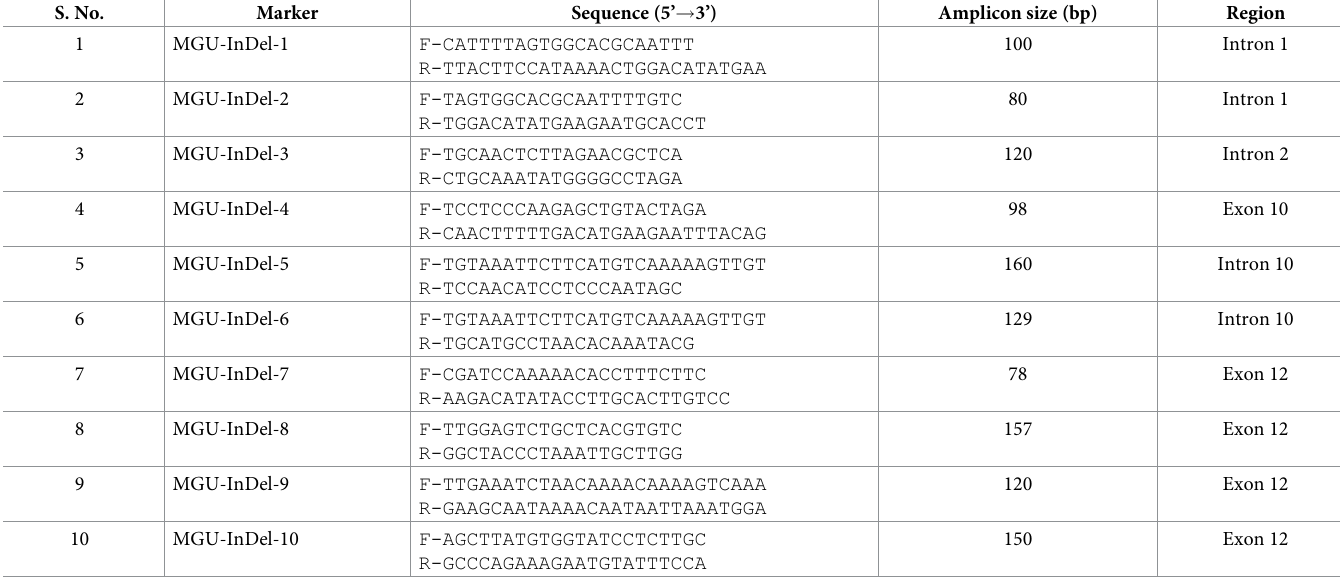
Table 1. Details of markers used in Sh2 gene diversity